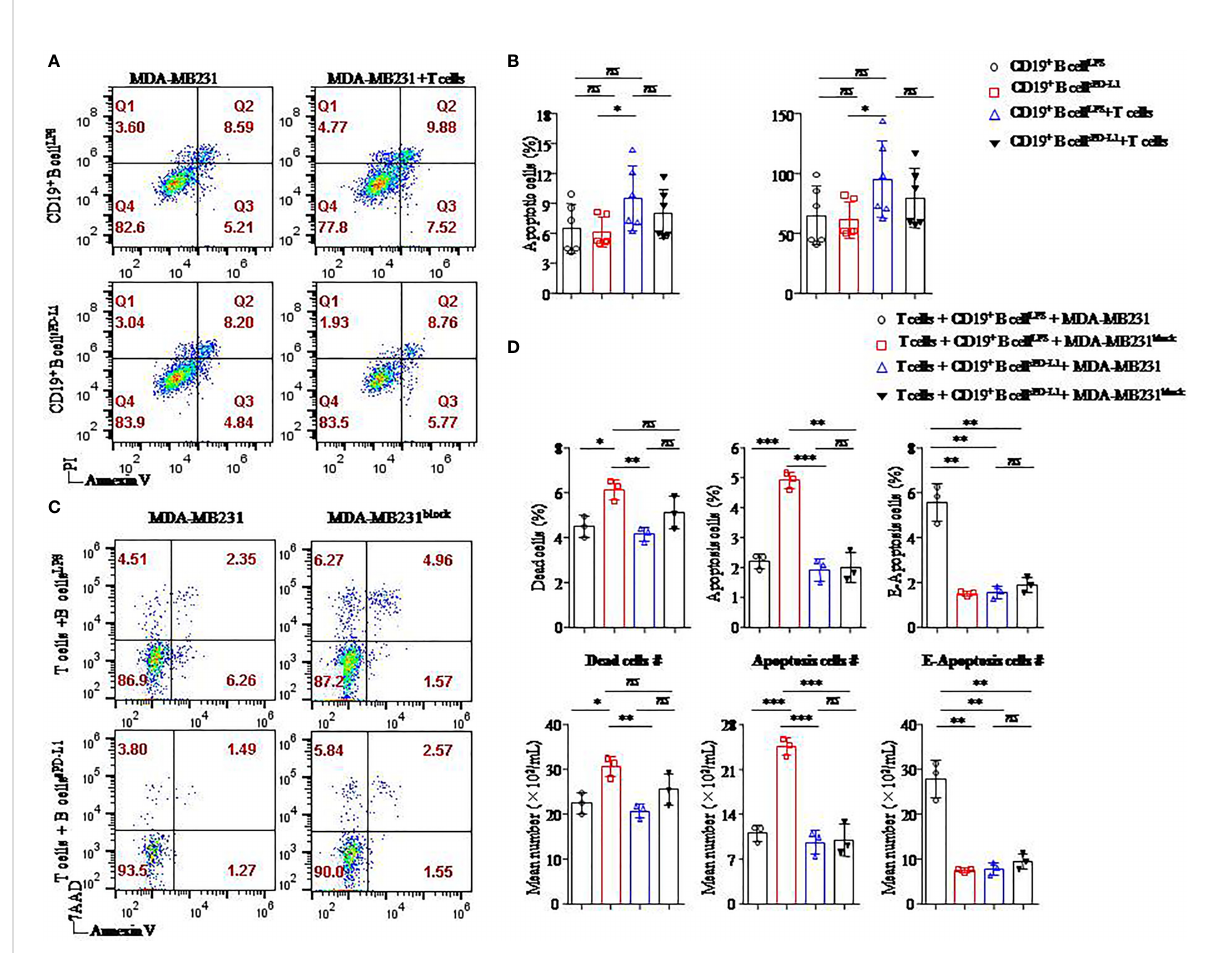
FIGURE 6 Breast cancer cell apoptosis was induced when the PD-L1 signal was blocked. Representative fl ow cytometry dot plot of apoptosis of PD-L1 hi MDA-MB231 cells cultured with CD4 + T cells and CD19 + B cells pretreated with LPS or sPD-L1 (A) . The percentage and absolute number of apoptotic cells were detected in PD-L1 hi MDA-MB231 cells (n = 6) cultured with CD19 + B cells pretreated with LPS or sPD-L1 with or without CD4 + T cells (B) . Representative fl ow cytometry dot plot of death, apoptosis, and E-apoptosis of PD-L1 hi MDA-MB231 cells with or without PD- L1 – blocking antibody treatment in the culture system including CD4 + T cells and B cells pretreated with LPS or sPD-L1 (C) . The percentage and the absolute number of dead, apoptotic, and E-apoptotic cells were detected in PD-L1 hi MDA-MB231 cells (n = 3) cultured with CD4 + T cells and CD19 + B cells pretreated with LPS or sPD-L1 with or without PD-L1 – blocking antibody treatment (D) . Data represent means ± SEM of at least three independent experiments and were analyzed by unpaired Student ’ s t -test. ns, not statistically signi fi cant. * P < 0.05, ** P < 0.01, and *** P <